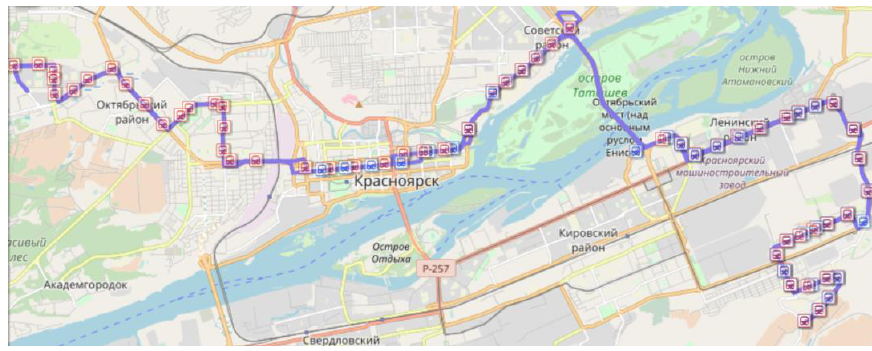
Fig 5. Scheme of bus route № 85.